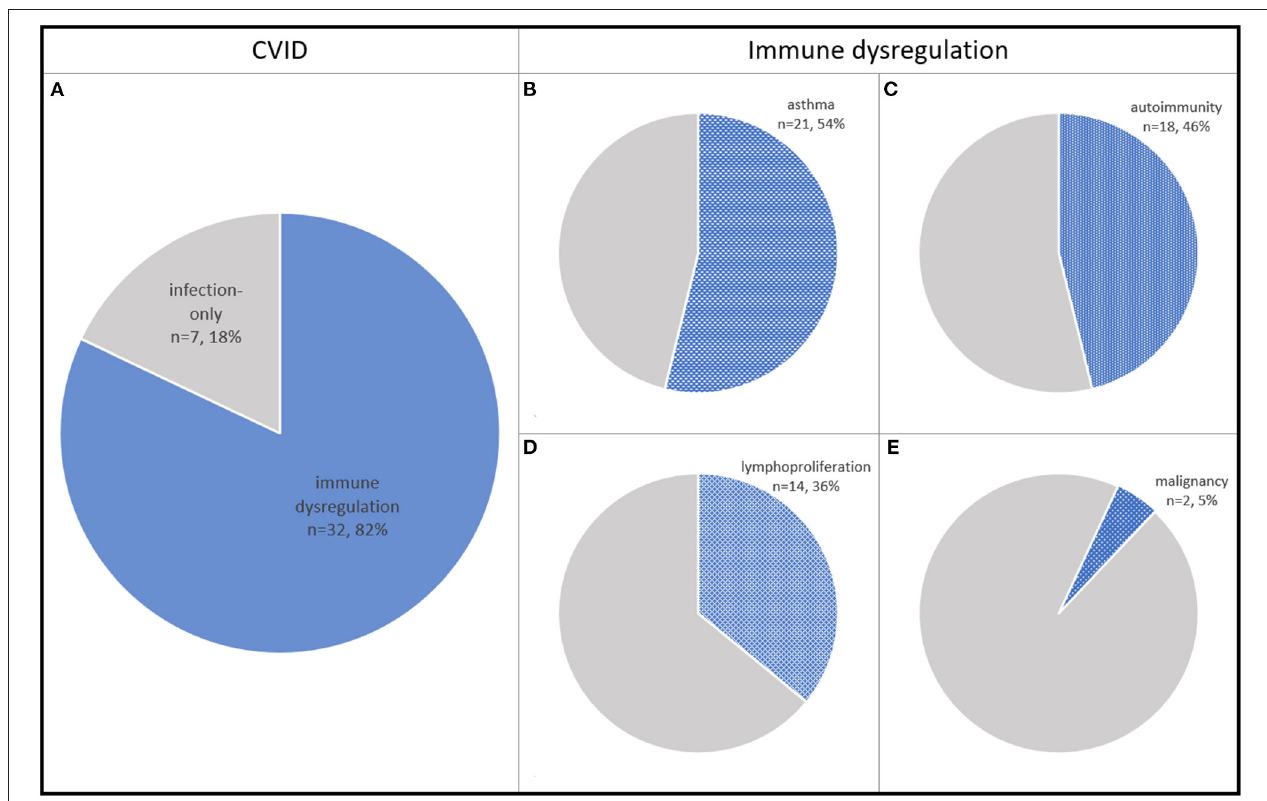
FIGURE 1 | The proportions of CVID children with immune dysregulation features (A) , asthma (B) , autoimmunity (C) , lymphoproliferation (D) , and malignancy (E) .